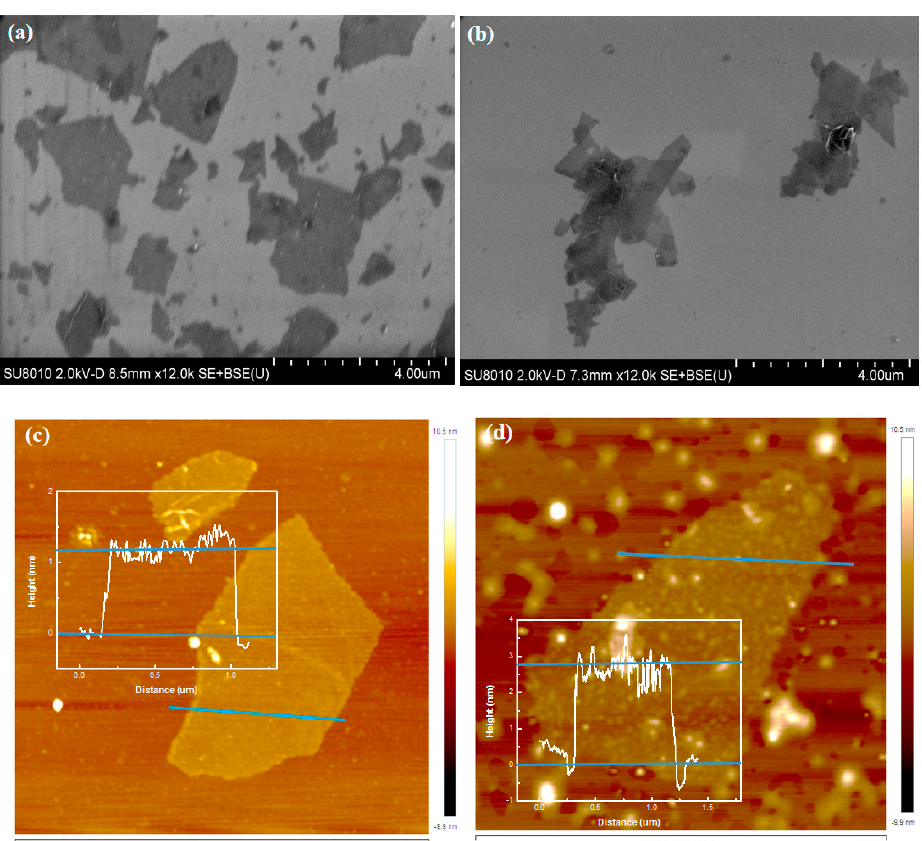
Figure 3. ( a , b ) SEM images of GO and ODA@GO, respectively; ( c , d ) AFM images of GO and ODA@GO, respectively.